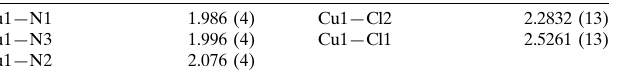
Selected bond lengths (A˚ ).